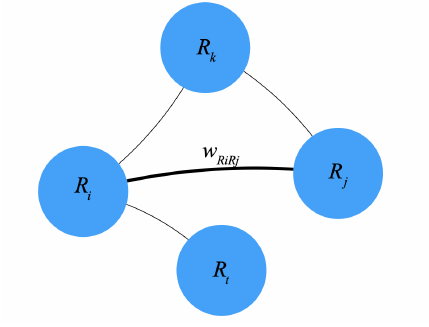
Figure 4. Weights of interactions in M 1